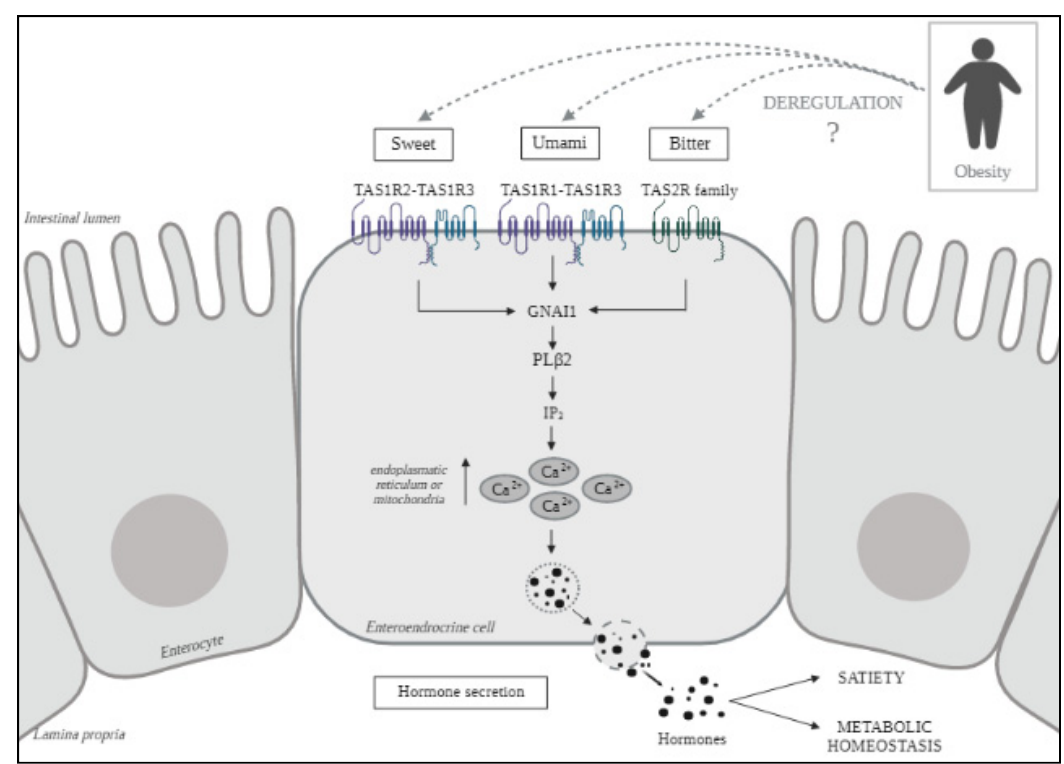
Figure 1. Nutrient taste receptors signaling in enteroendrocrine cells. The detection of sugars molecules is mediated by TAS1R2–TAS1R3, umami sensing is achieved by TAS1R1–TAS1R3 and bitter detection is mediated by the TAS2R family. When nutrients bind their receptors, the signaling pathway is activated, causing an increase of intracellular calcium that ultimately induces the release of hormones involved in the process of satiety and metabolic homeostasis [24]. Obesity seems to deregulate this pathway but the precise mechanism is still unknown [25]. TAS1, taste 1 receptor family; TAS2, taste 2 receptor family; GNAI1, guanine nucleotide-binding protein G; PL β 2, phosphatidylinositol phospholipase C; IP 3 , inositol trisphosphate; Ca 2+ , calcium 2+ .